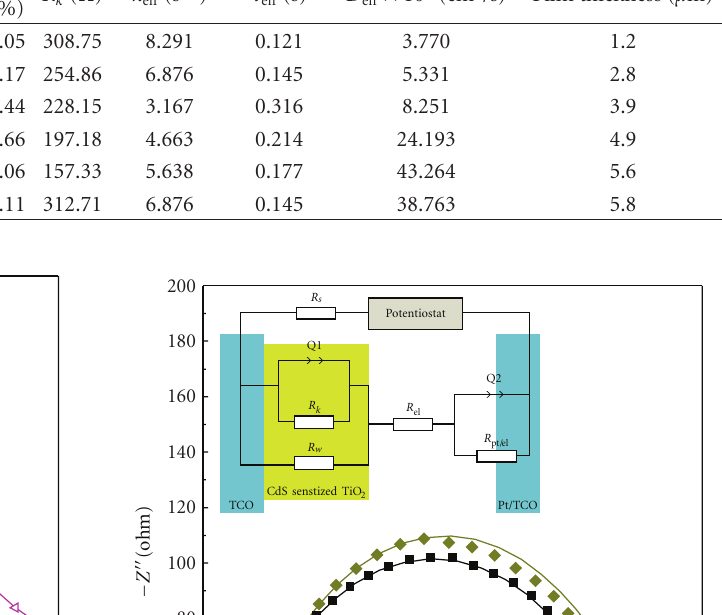
Table 1: A summary of photovoltaic and photoelectron transport properties of CdS QD-SSCs under AM1.5 condition. Sample